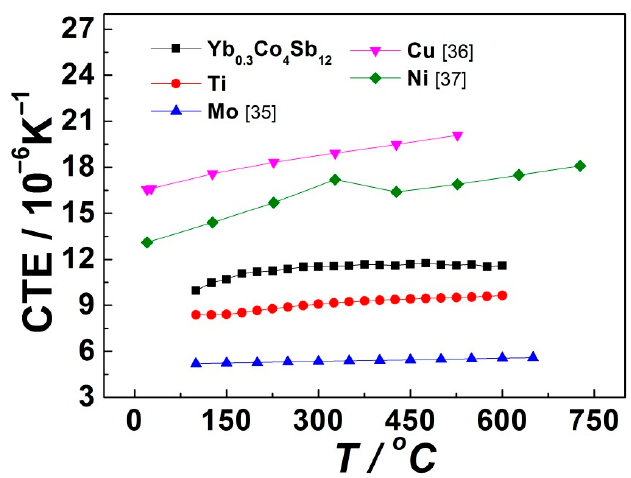
Figure 1. Variation of the CTE with temperature for Yb 0.3 Co 4 Sb 12 , Ti, Mo, Cu, and Ni, Data for Mo, Cu, and Ni are from references [35–37] respectively.